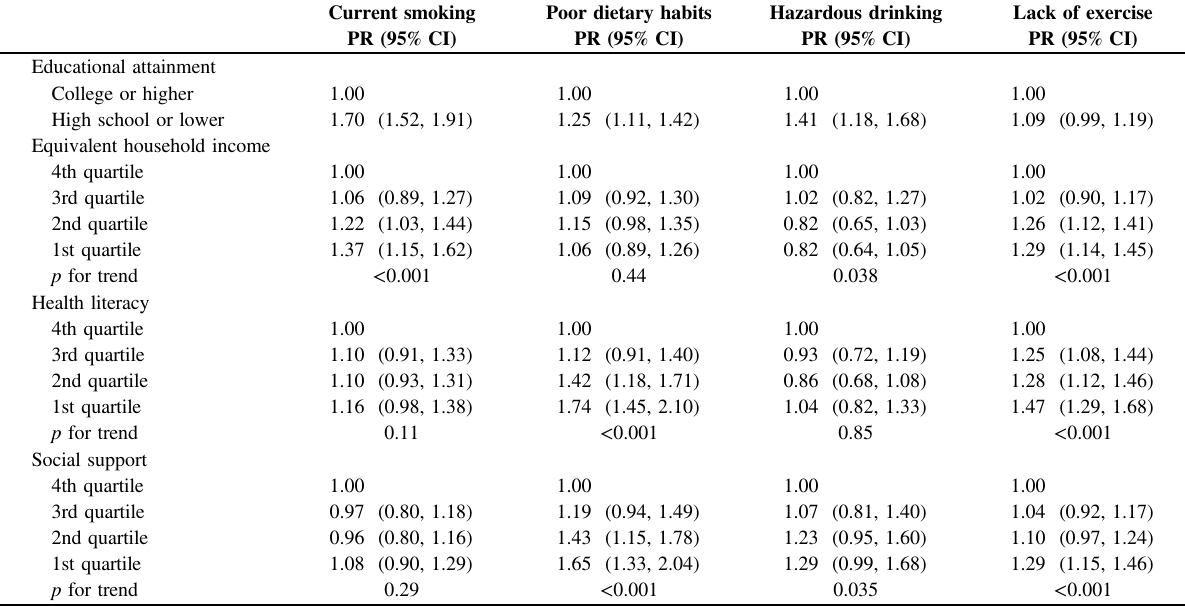
Table 2 Associations of education, income, health literacy, and social support with health-related